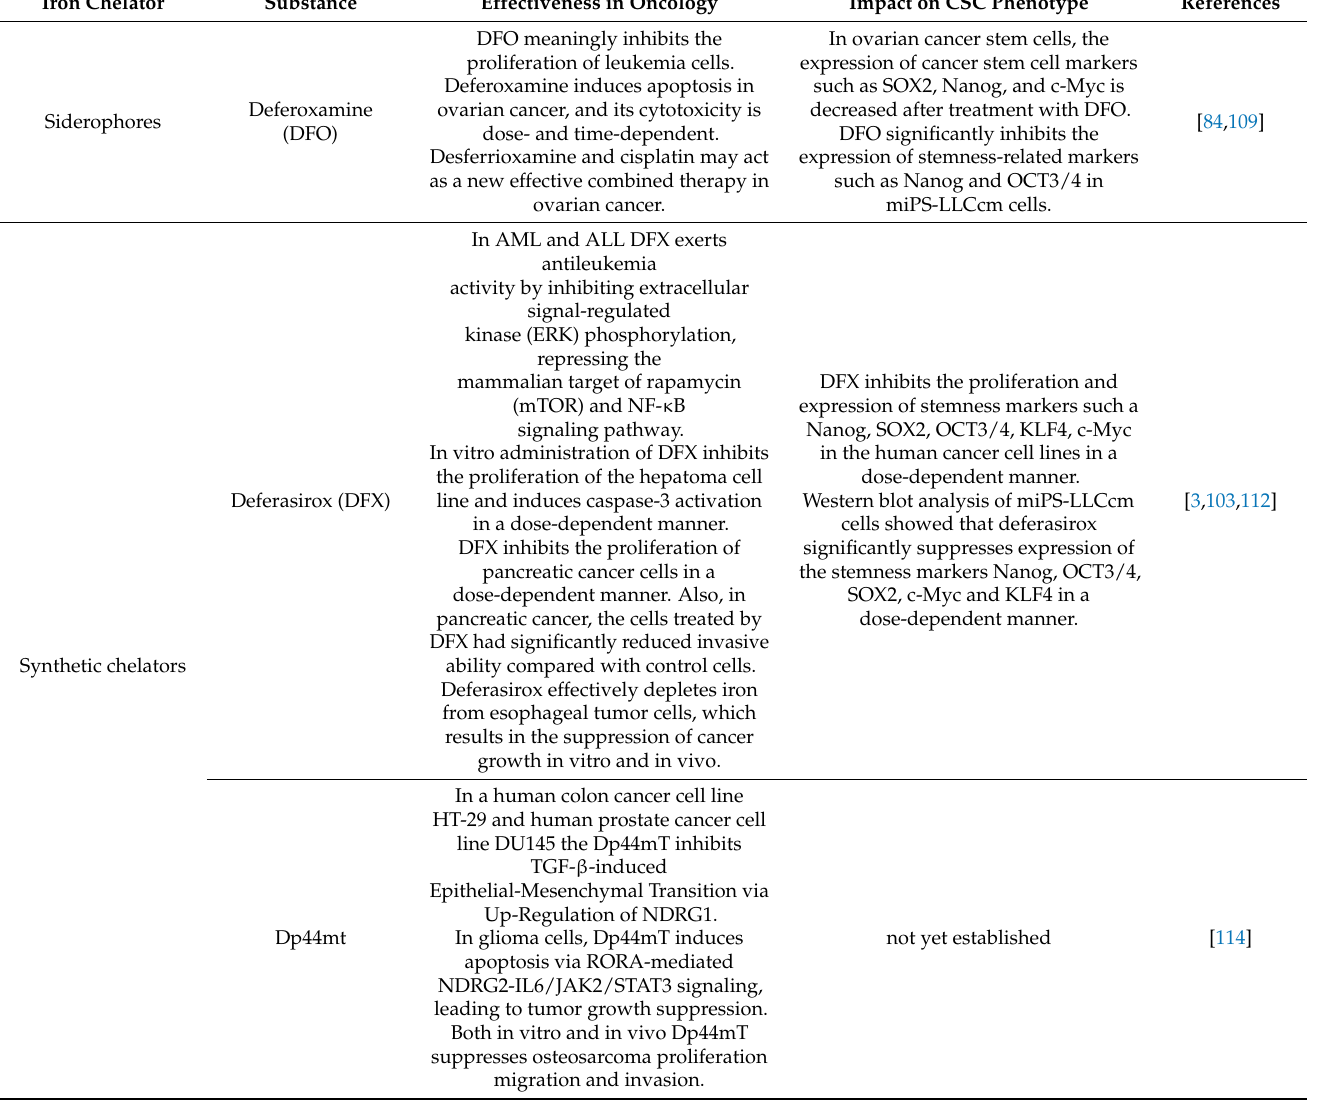
Table 2. Summary of iron chelators and their effect on cancer cells and stemness-related